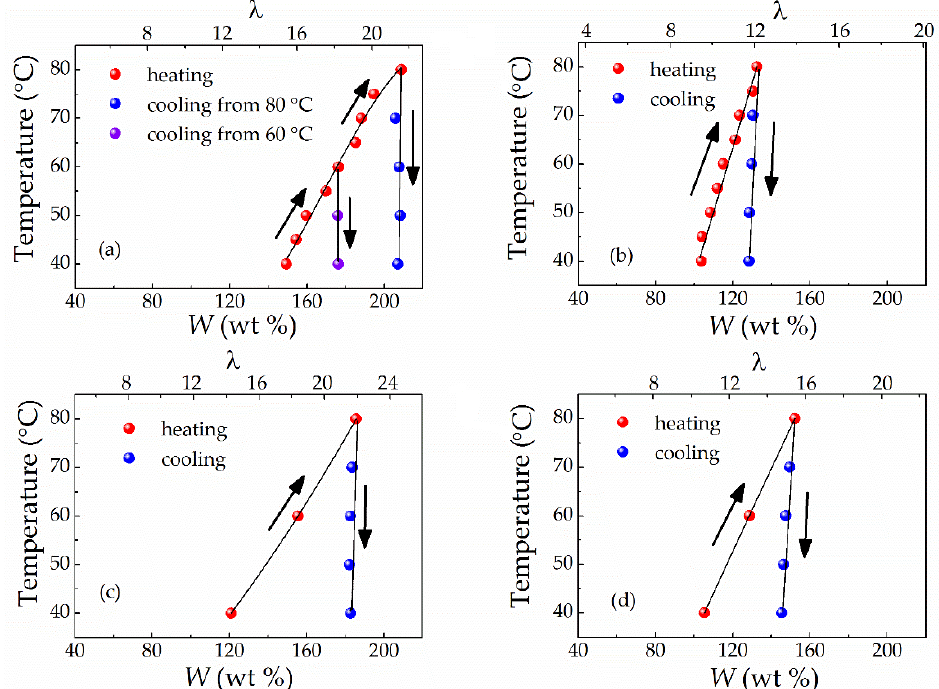
Figure 4. Dependence of the weight uptake ( W ) and molar uptake ( λ ) of a solvent of the Li-Nafion membrane vs. mixing temperature at heating and cooling mode for the following solvents: ethylene carbonate (EC) ( a ); sulfolane (SL) ( b ); EC/SL with ω (SL) = 0.2 ( c ); EC/SL with ω (SL) = 0.7 ( d